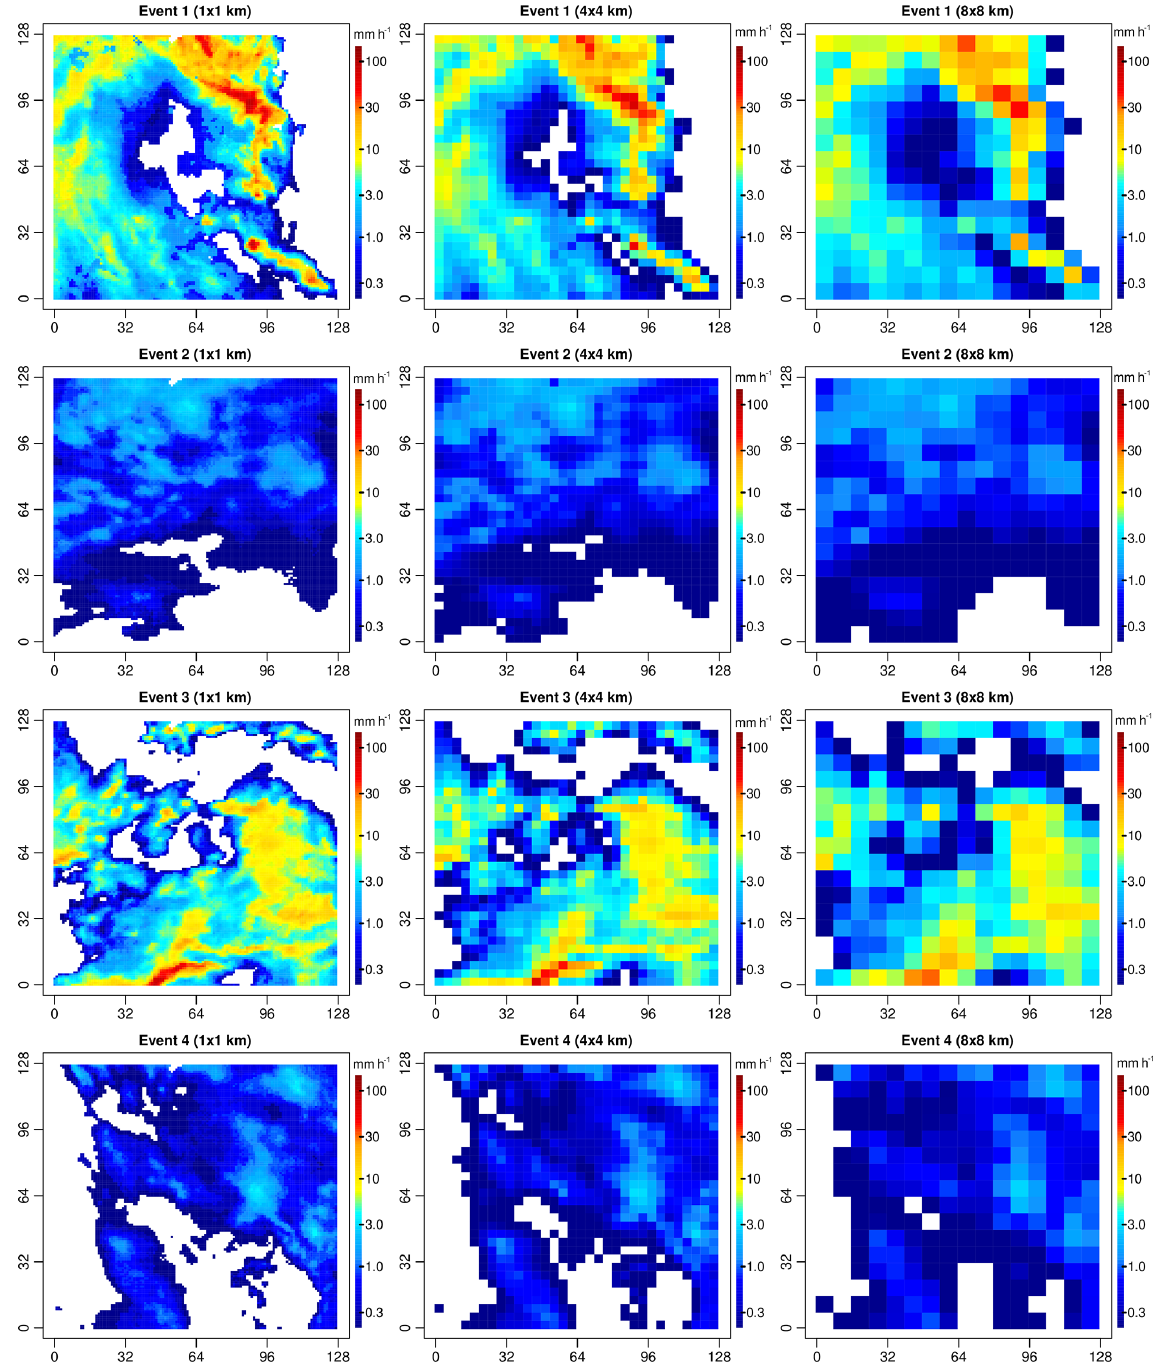
Figure 6. Original 1km × 1km and upscaled (4km × 4km and 8km × 8km) 5min radar rainfall snapshots for events 1 to 4.